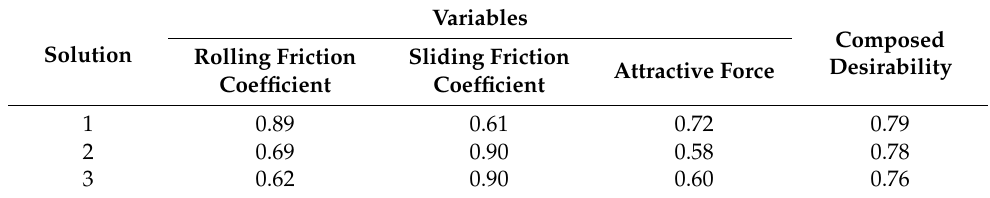
Table 6. Optimization solutions.